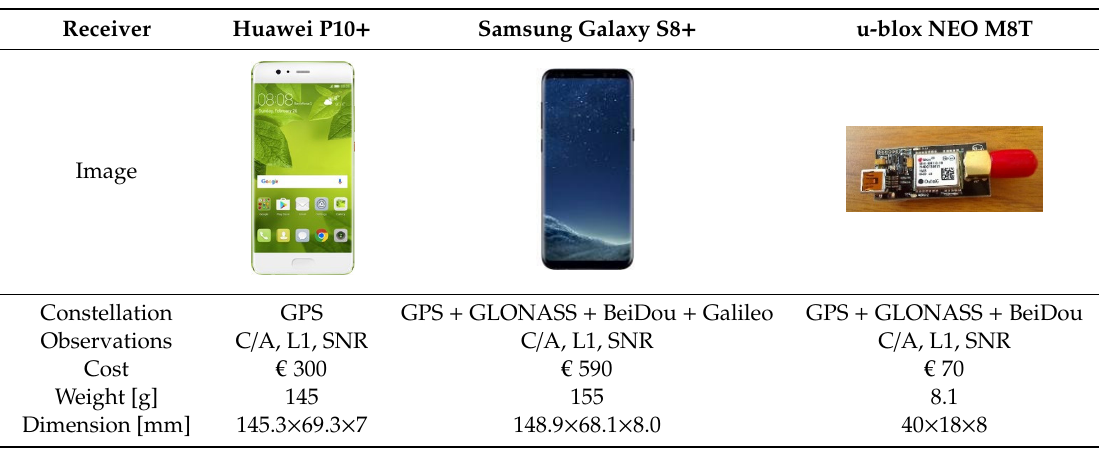
Table 1. The instruments used in these tests.